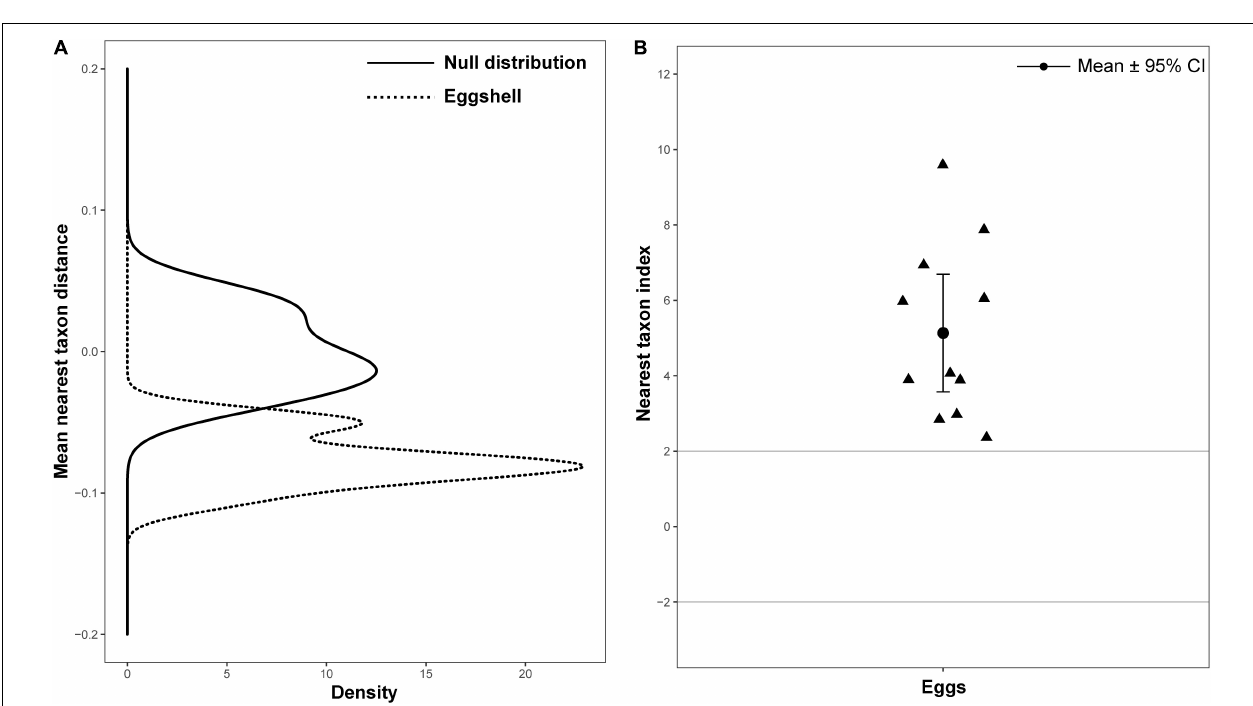
FIGURE 4 | β -Diversity of the bacterial community across eggshells and maternal and environmental samples. Non-metric multidimensional scaling (NMDS) plots based on Bray-Curtis distances (A) and weighted UniFrac distances (B) of eggshell and source communities. Each point represents the bacterial community of a sample; the color and shape of the point represent different sample types.